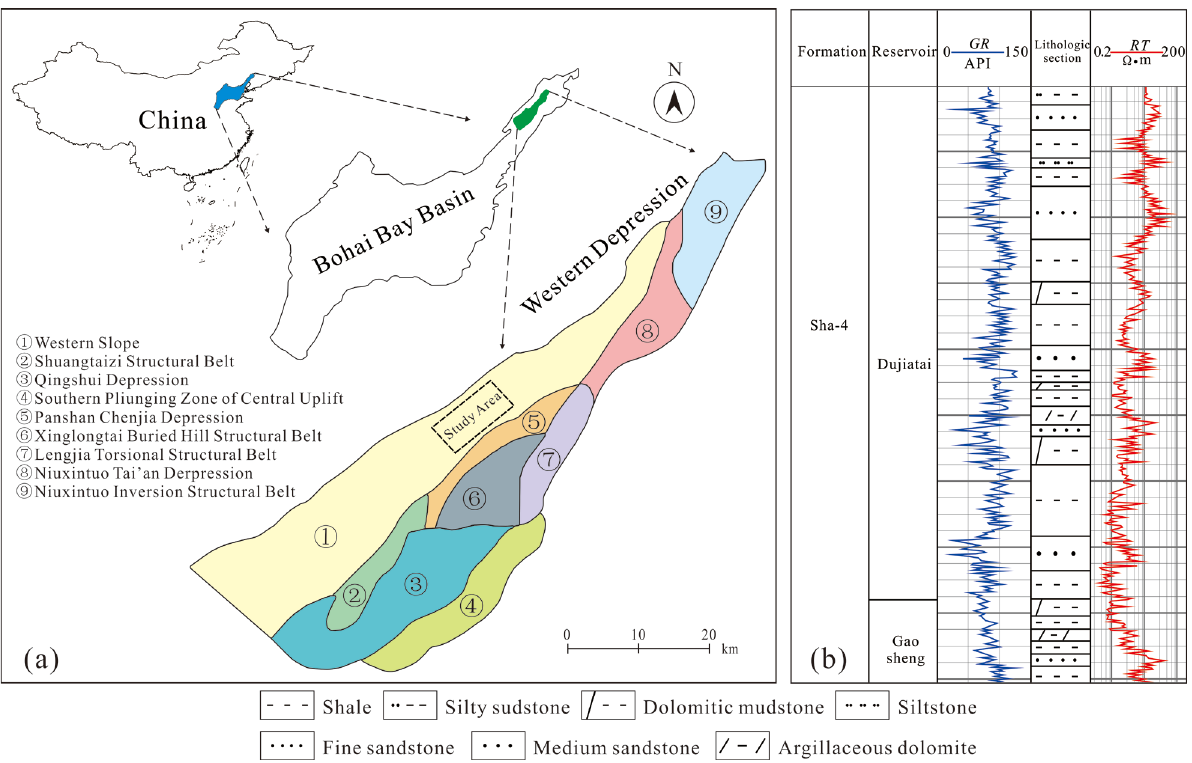
Figure 1. ( a ) Location of the study area; ( b ) Comprehensive histogram of Sha-4 member.